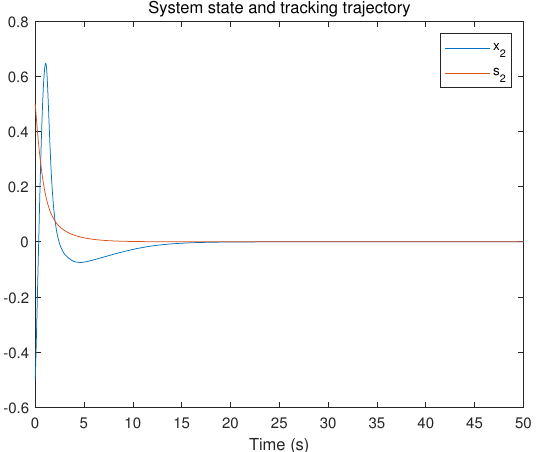
Figure 10. System state x 2 and its tracking trajectory when η 1 = − 0.2 and η 2 = 0.2.